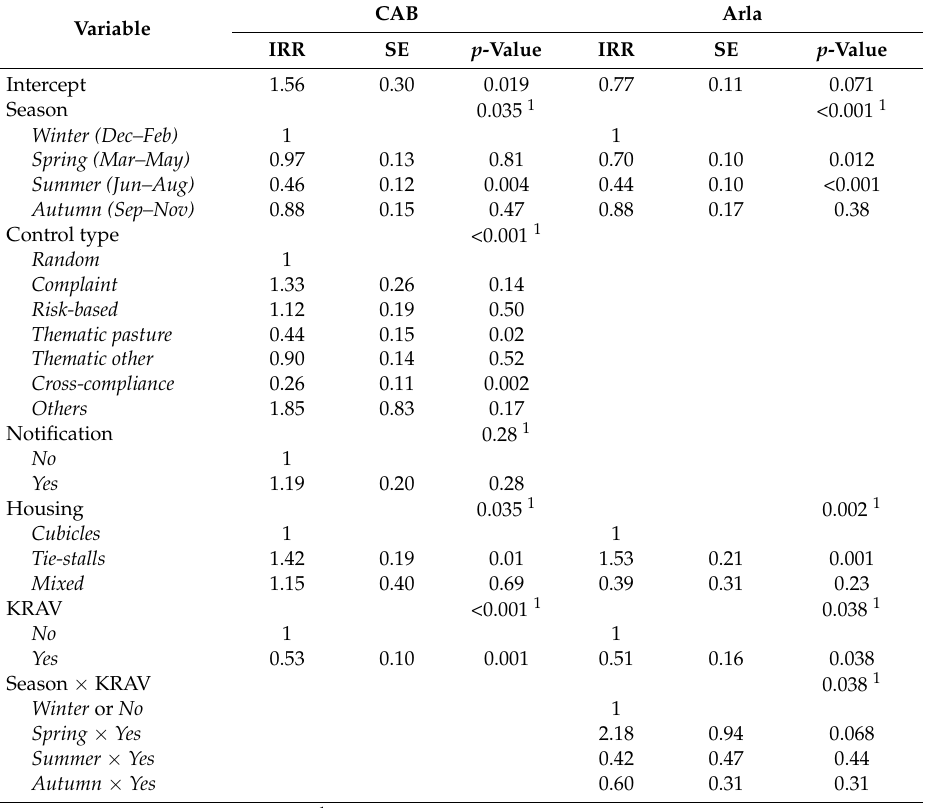
Table 3. Final multivariable negative binomial regression model used to investigate the effect of different variables on the odds for a higher number of non-compliance during animal welfare control made by the CAB (County Administrative Board, official control) or Arla (on the private standard Arlagården) in the Swedish county of Västra Götaland during 2010–2013.